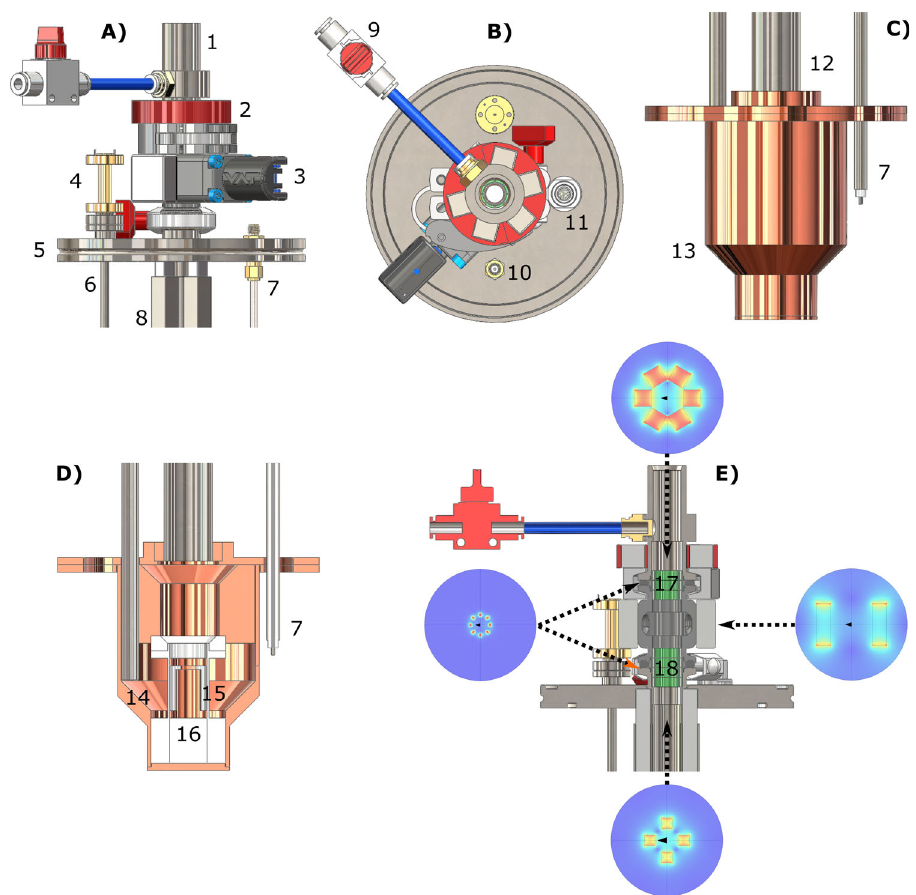
Fig. 6 DNP probe for sample extraction. Top and bottom part of the DNP probe are reported: top part front view ( A ), top part top view ( B ), bottom part front view ( C ), bottom part section view ( D ), top part front section view with simulated permanent magnets fi eld pro fi le cross-section ( E ). Numbers indicate the main components: sample loading chamber (1), loading chamber hexagonal Halbach array placed around loading chamber (2), mini gate-valve with NdFeB permanent magnets (3), WR5-to-circular microwave transition (4), ISO-KF-100 fl ange (5), circular waveguide (6), NMR rigid coax-cable (7), squared Halbach array around probe stem/loading tube (8), loading chamber He gas purging line (9), NMR bulkhead SMA connector (10), Fischer connector for liquid helium level meter (11), probe stem (12), microwave cavity (13), 45° microwave mirror (14), pseudo Alderman-Grant coil (15), PTFE coil former (16), octagonal Halbach arrays inside KF16 fl anges (17,